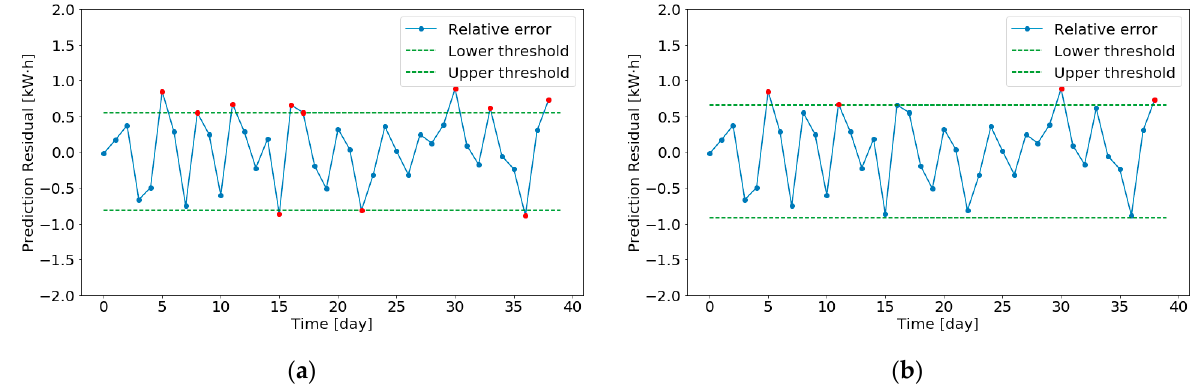
Figure 8. Prediction effect of GRU under 14-day sliding window.